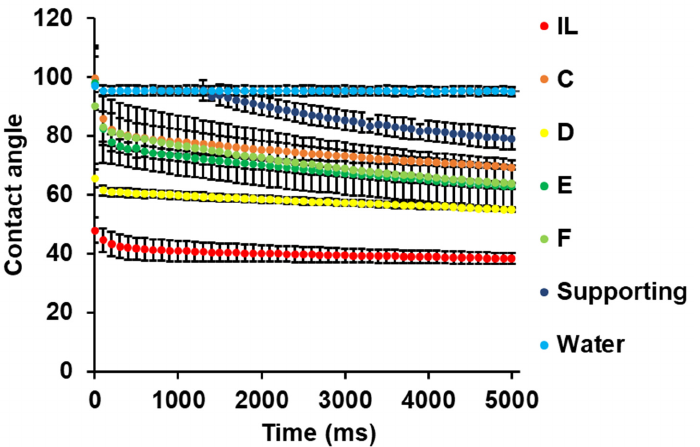
Figure 3. Contact angles of printer inks containing an IL and different Eudragit polymers. Infor- mation on the printer ink formulations is shown in Table 1 and in Section 2. These data represent the means ± standard deviations ( n = 3).